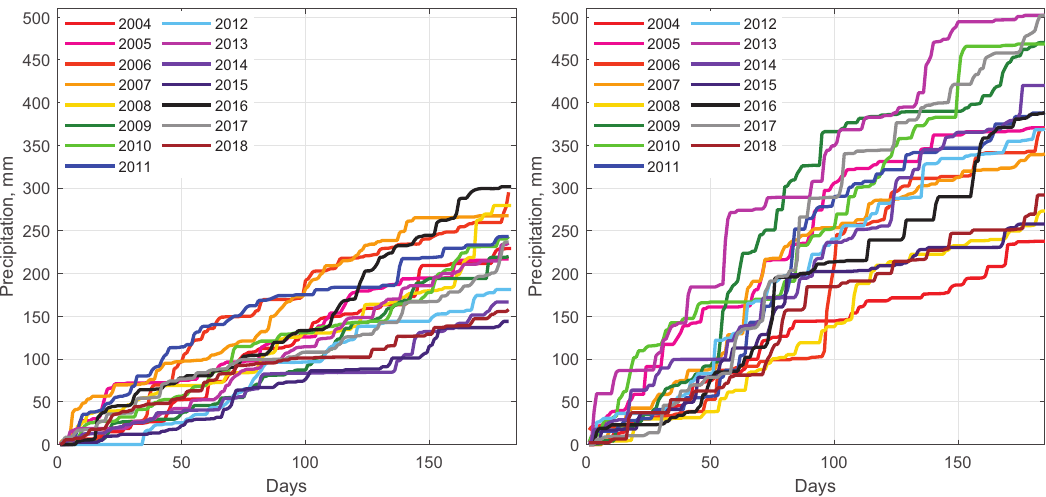
Figure 19. Cumulative sum of precipitation calculated for each season. The winter seasons (left panel) and the summer seasons (right